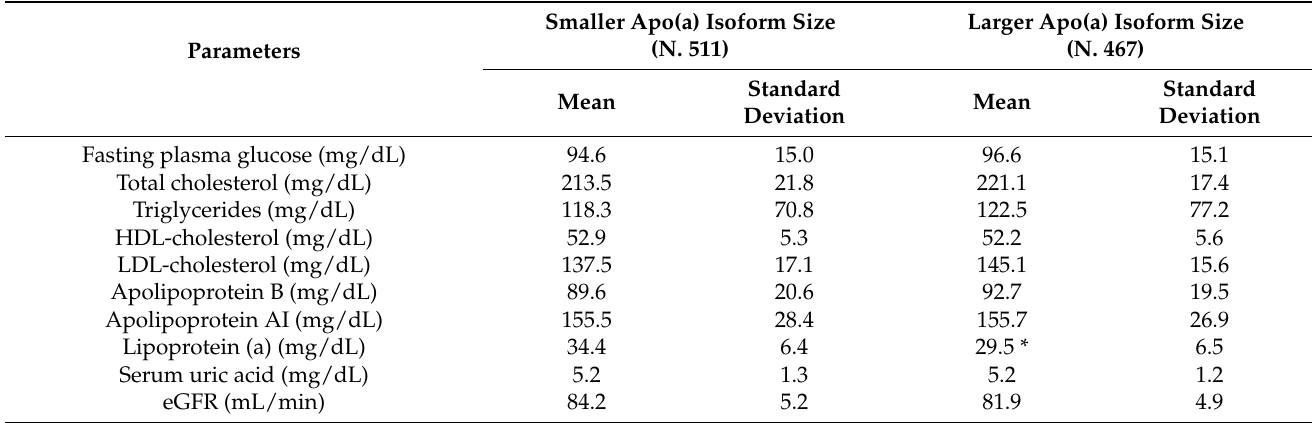
Table 3. Most clinically relevant laboratory characteristics of the population sample, reported by apo(a) isoform size.